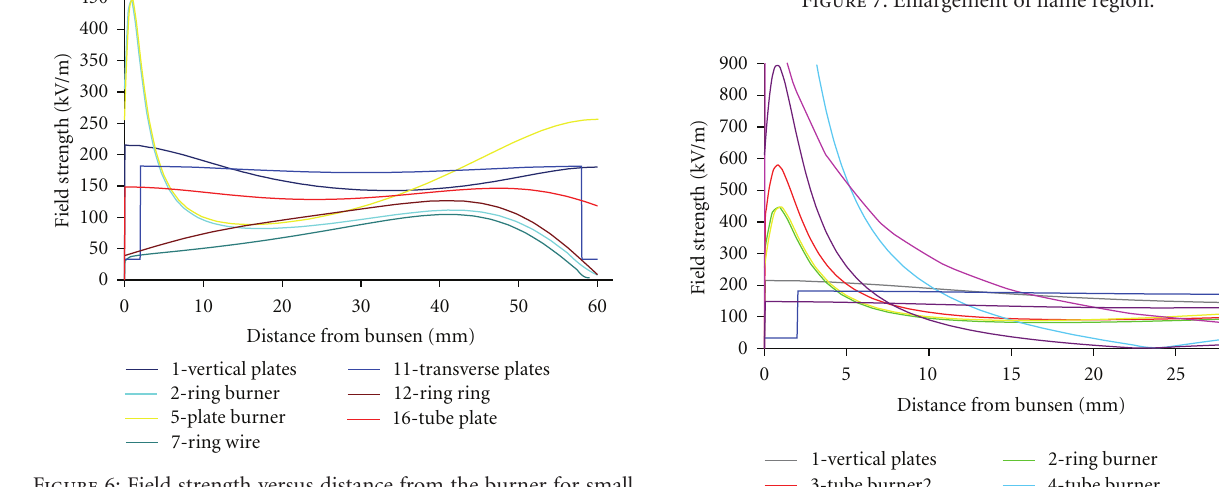
Figure 6: Field strength versus distance from the burner for small field strengths.